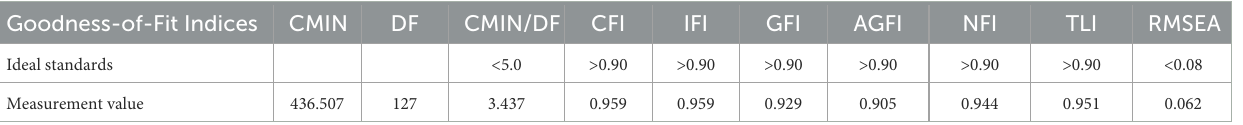
TABLE 7 Model fitness indices for the modified model. Goodness-of-Fit Indices CMIN DF CMIN/DF CFI IFI GFI AGFI NFI TLI RMSEA Ideal standards <5.0 >0.90 >0.90 >0.90 >0.90 >0.90 >0.90 <0.08